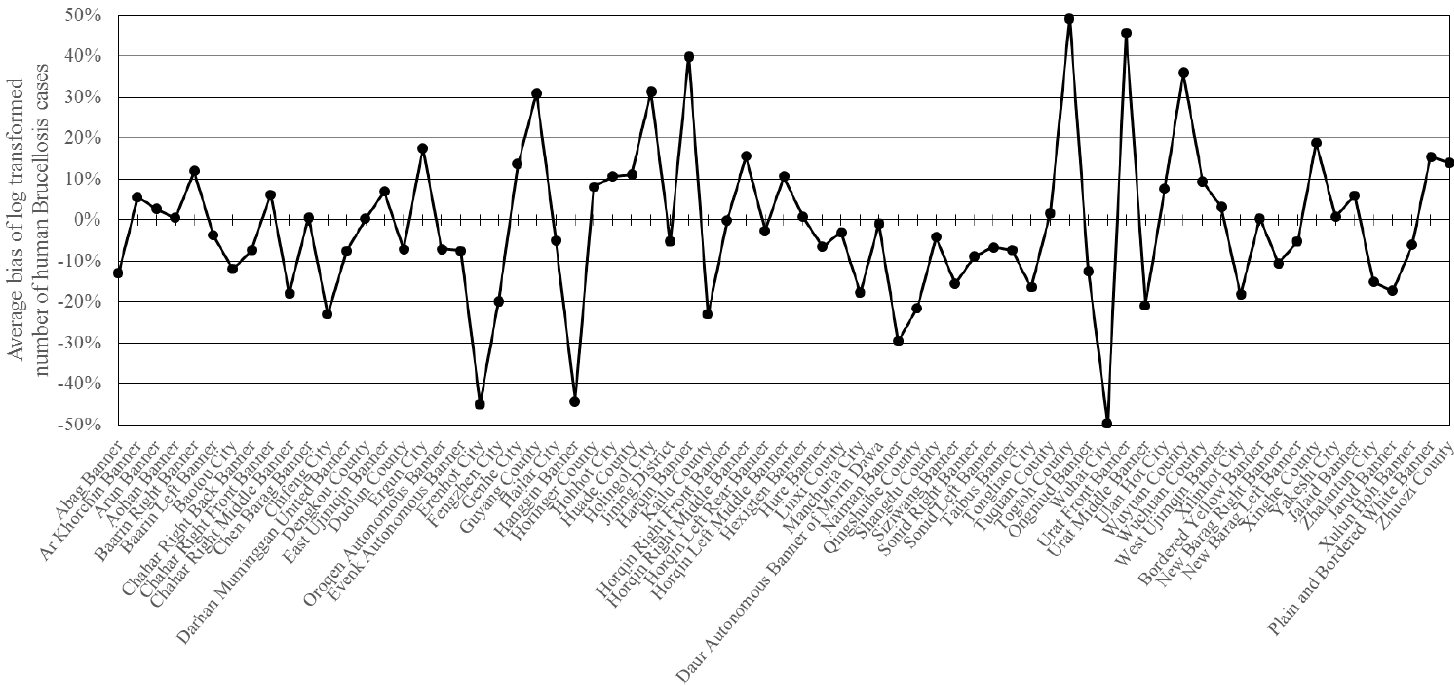
Figure 4. Percent errors of the log-transformed numbers of human brucellosis cases during 2006–2008 in 71 out of 89 counties in Inner Mongolia, China. The percent errors in the remaining 18 counties, outside of the − 50% to 50% error range, were described in the text, but left out in this figure for the sake of clarity.